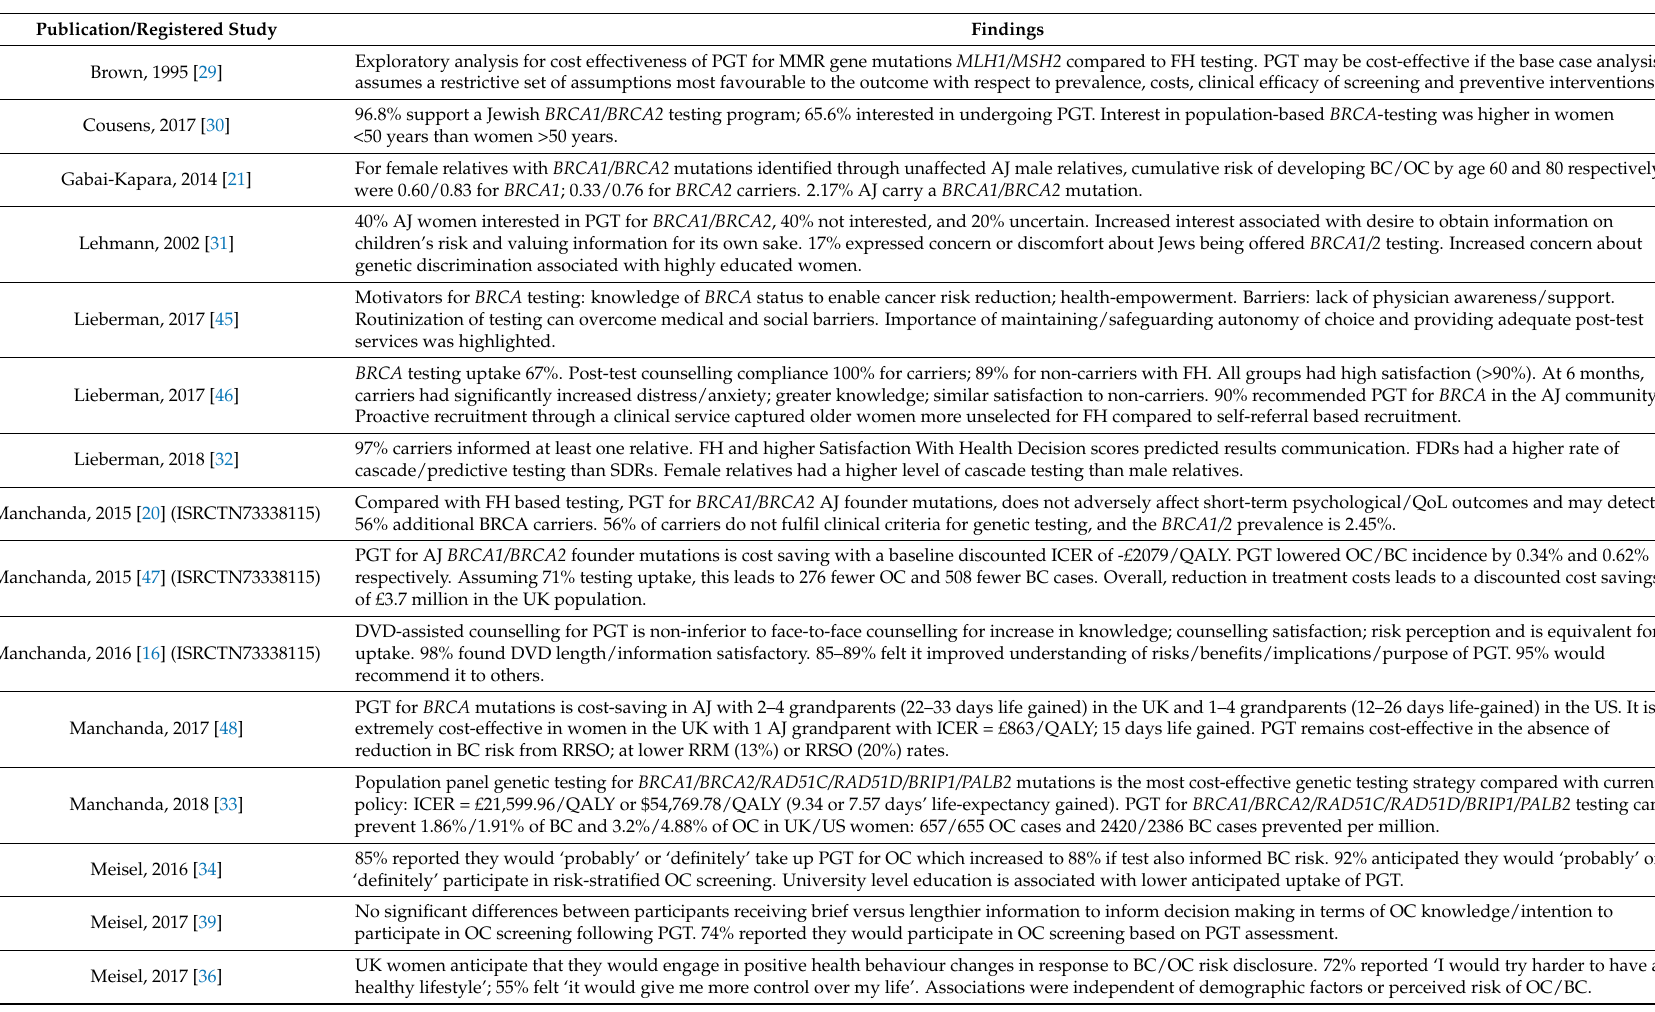
Table 3. Findings of publications and registered studies reporting population genetic testing